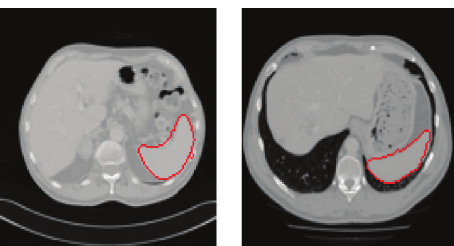
Figure 10: Segmentation results of spleen using the proposed